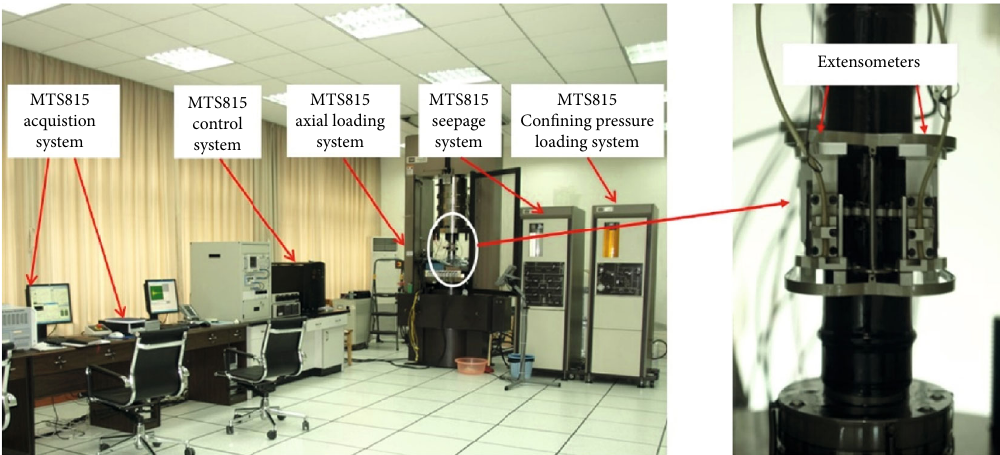
Figure 2: Rock mechanics experimental system of MTS815 and installation of